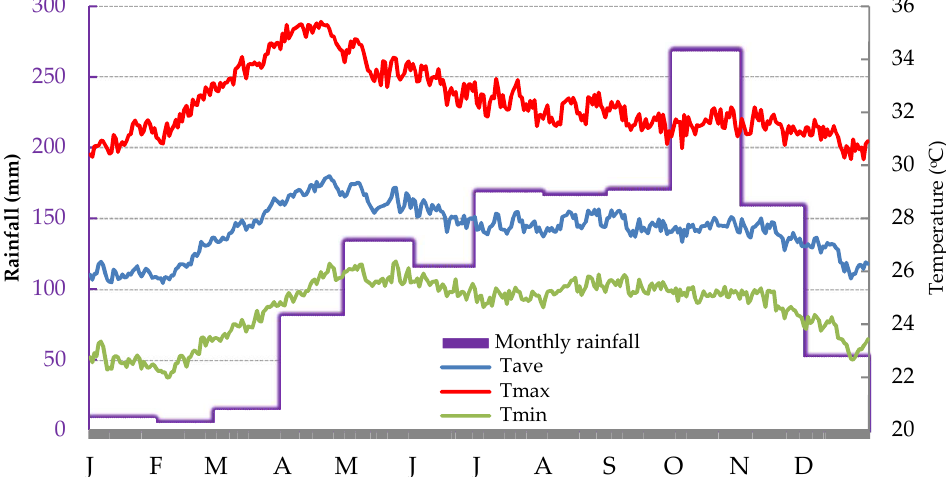
Figure 2. Average monthly rainfall, daily mean temperature (Tave), daily maximum temperature (Tmax), and daily minimum temperature (Tmin) during the period 1978–2016, collected from Southern Regional Hydrometeorology Center in Vietnam.